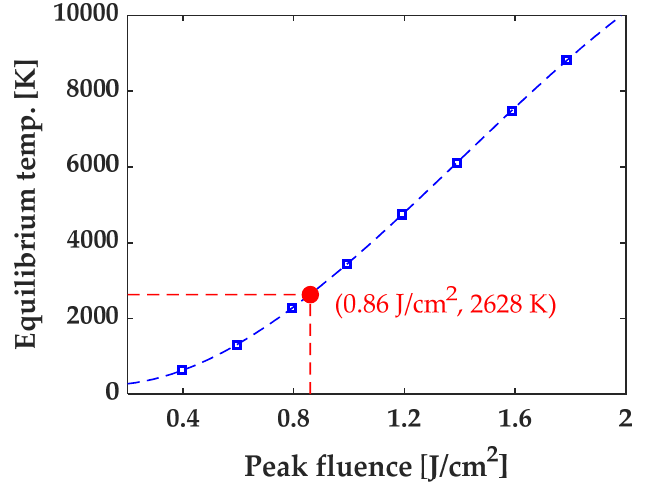
Figure 5. Equilibrium temperature extracted from TTM simulation results obtained at different fluences, red point indicating that boiling temperature of Si (2628 K [35]) is reached at a fluence of 0.86 J/cm 2 .